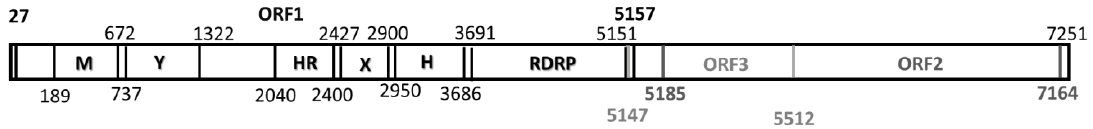
Figure 1. Graphic representation of the complete sequence MXCDg3_B1c|_2016 and capsid analysis.